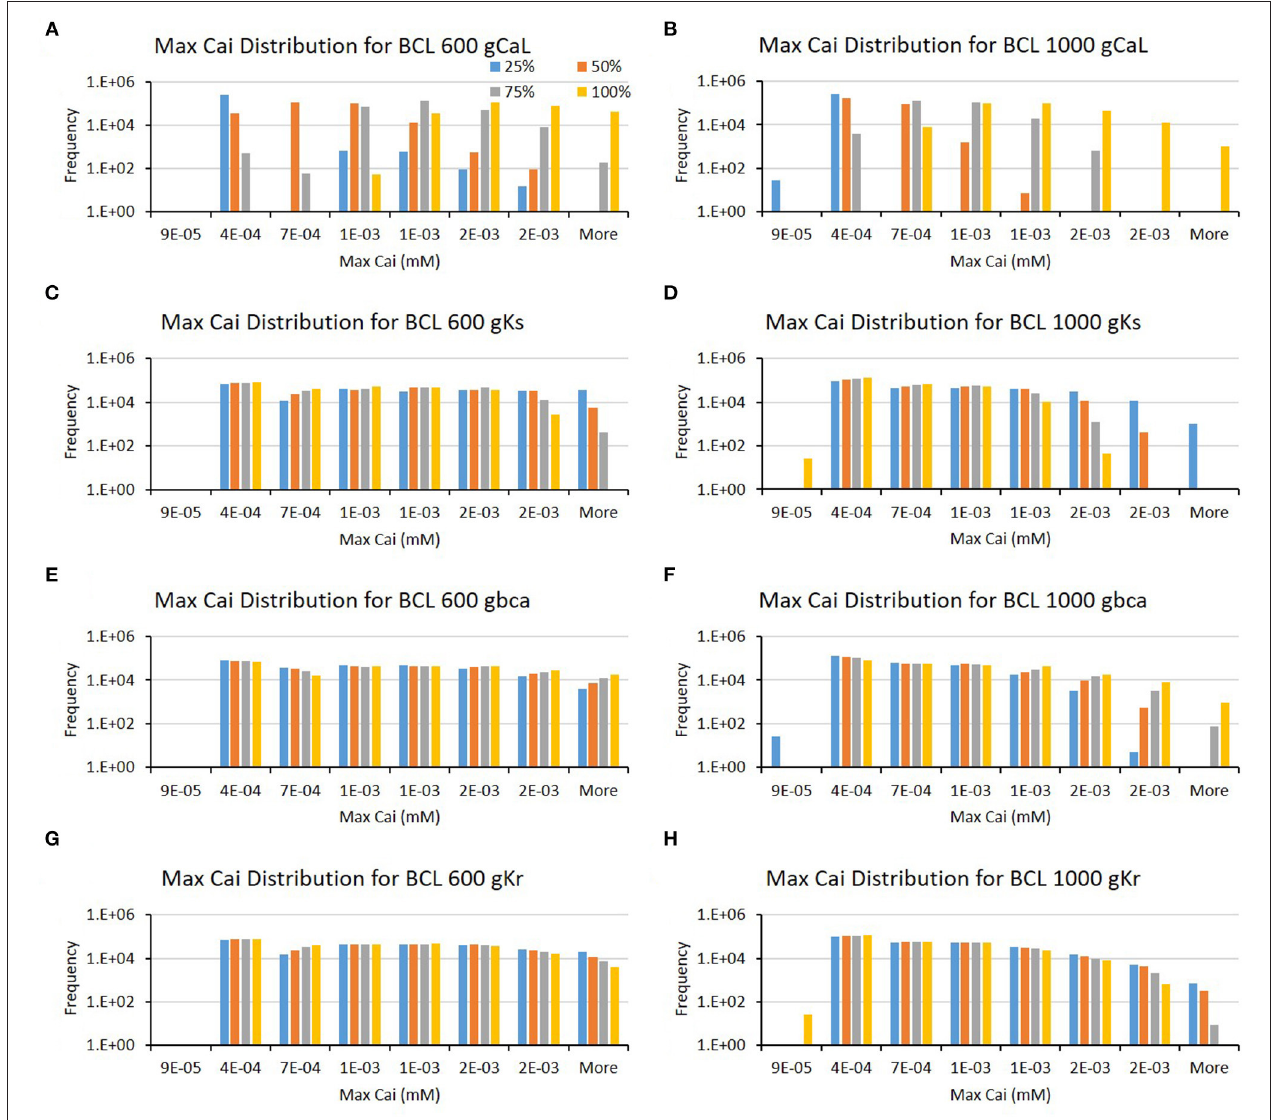
FIGURE 5 | The bar charts show the influence of major ion channels (based on Table 1 ) for increasing the max Cai [for BCL 600ms (A,C,E,G) and for BCL 1,000ms (B,D,F,H) ]. The x-axis is the max Cai groups in millimolar, and the y-axis is the frequency (number of appearance of max Cai groups) in logarithmic scale. Four conductance variations are applied